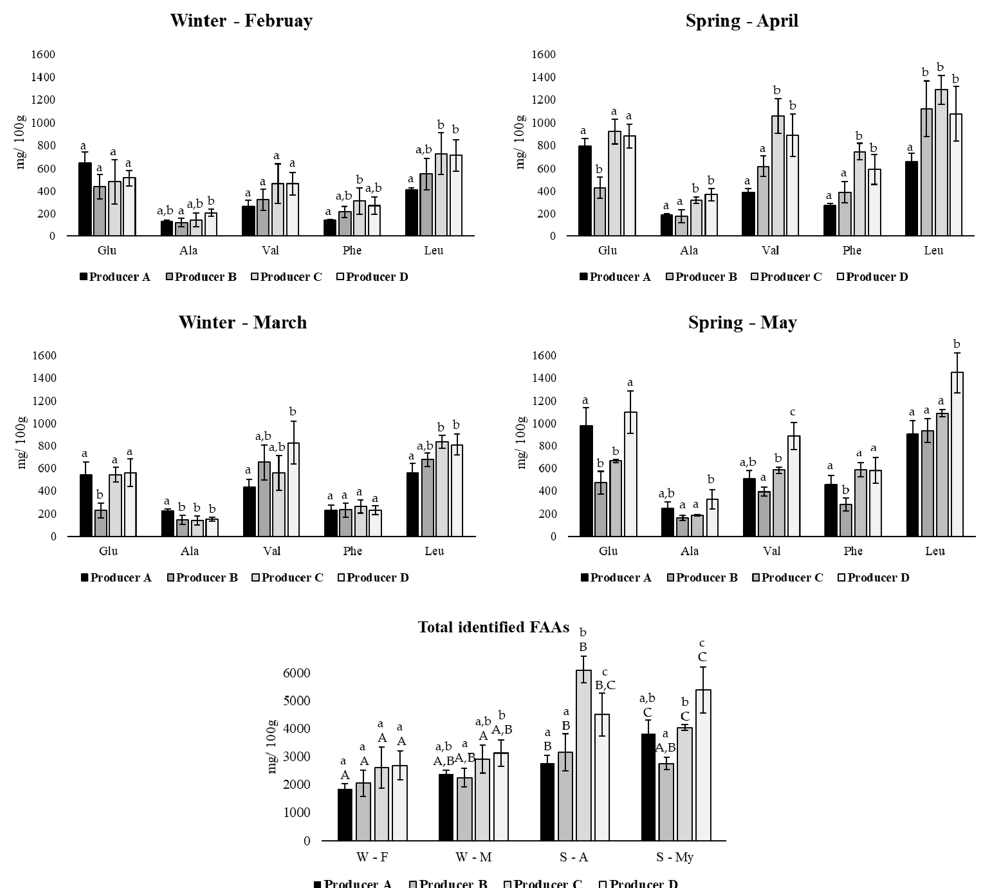
Figure 2. Most incident free amino acids (FAAs; mean ± standard deviation; mg/100 g) and total identified FAAs in samples from producers A, B, C and D, during four consecutive months. W—winter; S—Spring; F—February; M—March; A—April; My—May. Different superscript letters correspond to significant differences ( p < 0.05). Lowercase letters were used to compare distinct producers (A, B, C and D) in each month (F, M, A, My), while uppercase letters were used to compare each producer during four consecutive months.